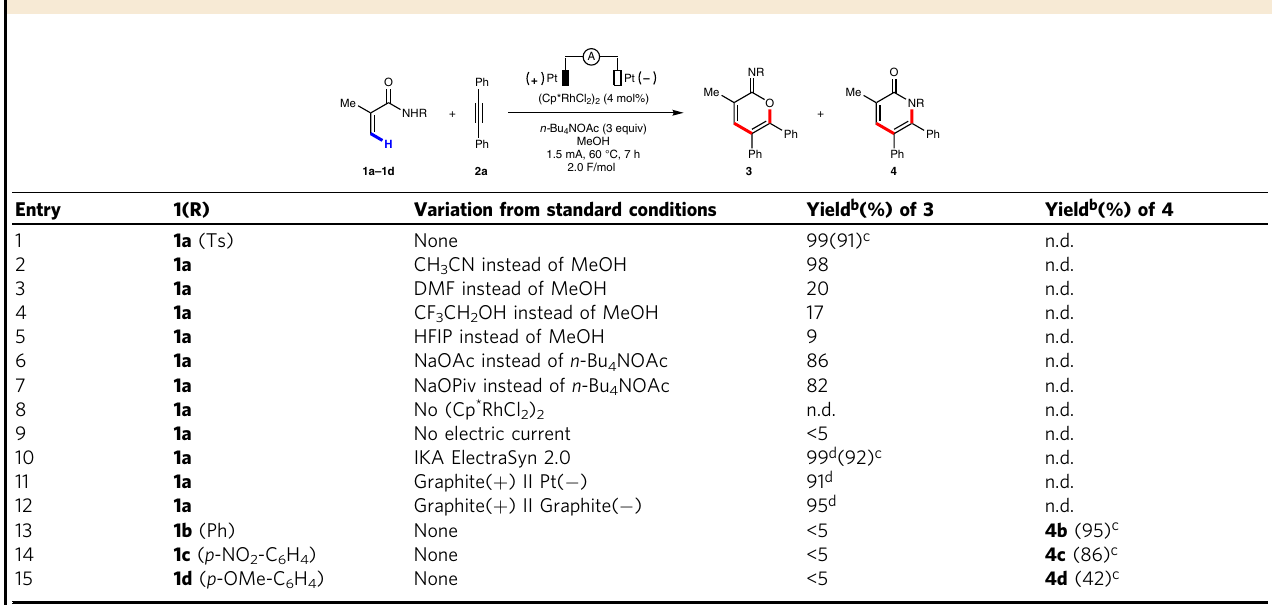
Table 1 Annulation optimization with acrylamide 1a and diphenylacetylene a